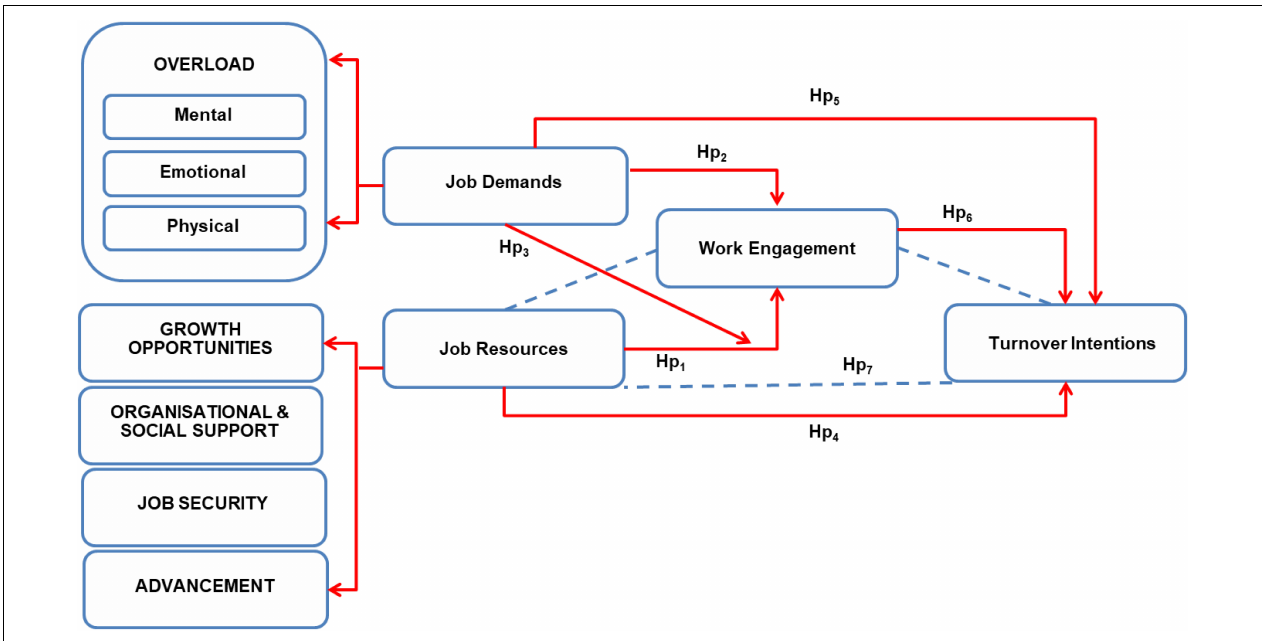
FIGURE 1 | Theoretical model of the relationships between the variables. Hp,